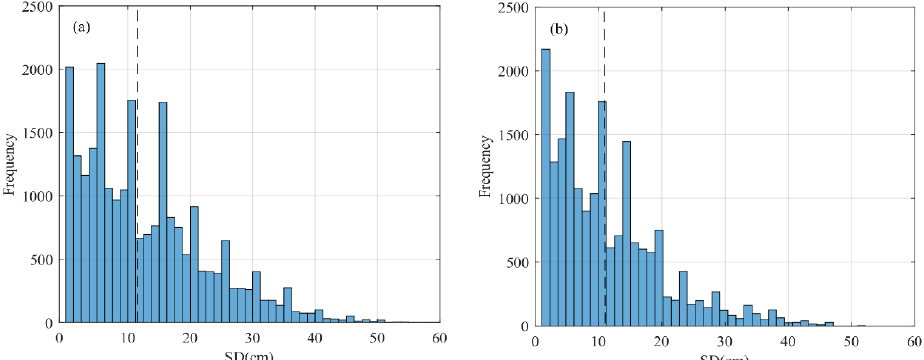
Figure 10. Histograms of SD observations from ground meteorological station dataset. ( a ) Training samples and ( b ) validation samples. The mean values (black dashed lines) are equal to 11.68 cm and 10.98 cm, respectively.